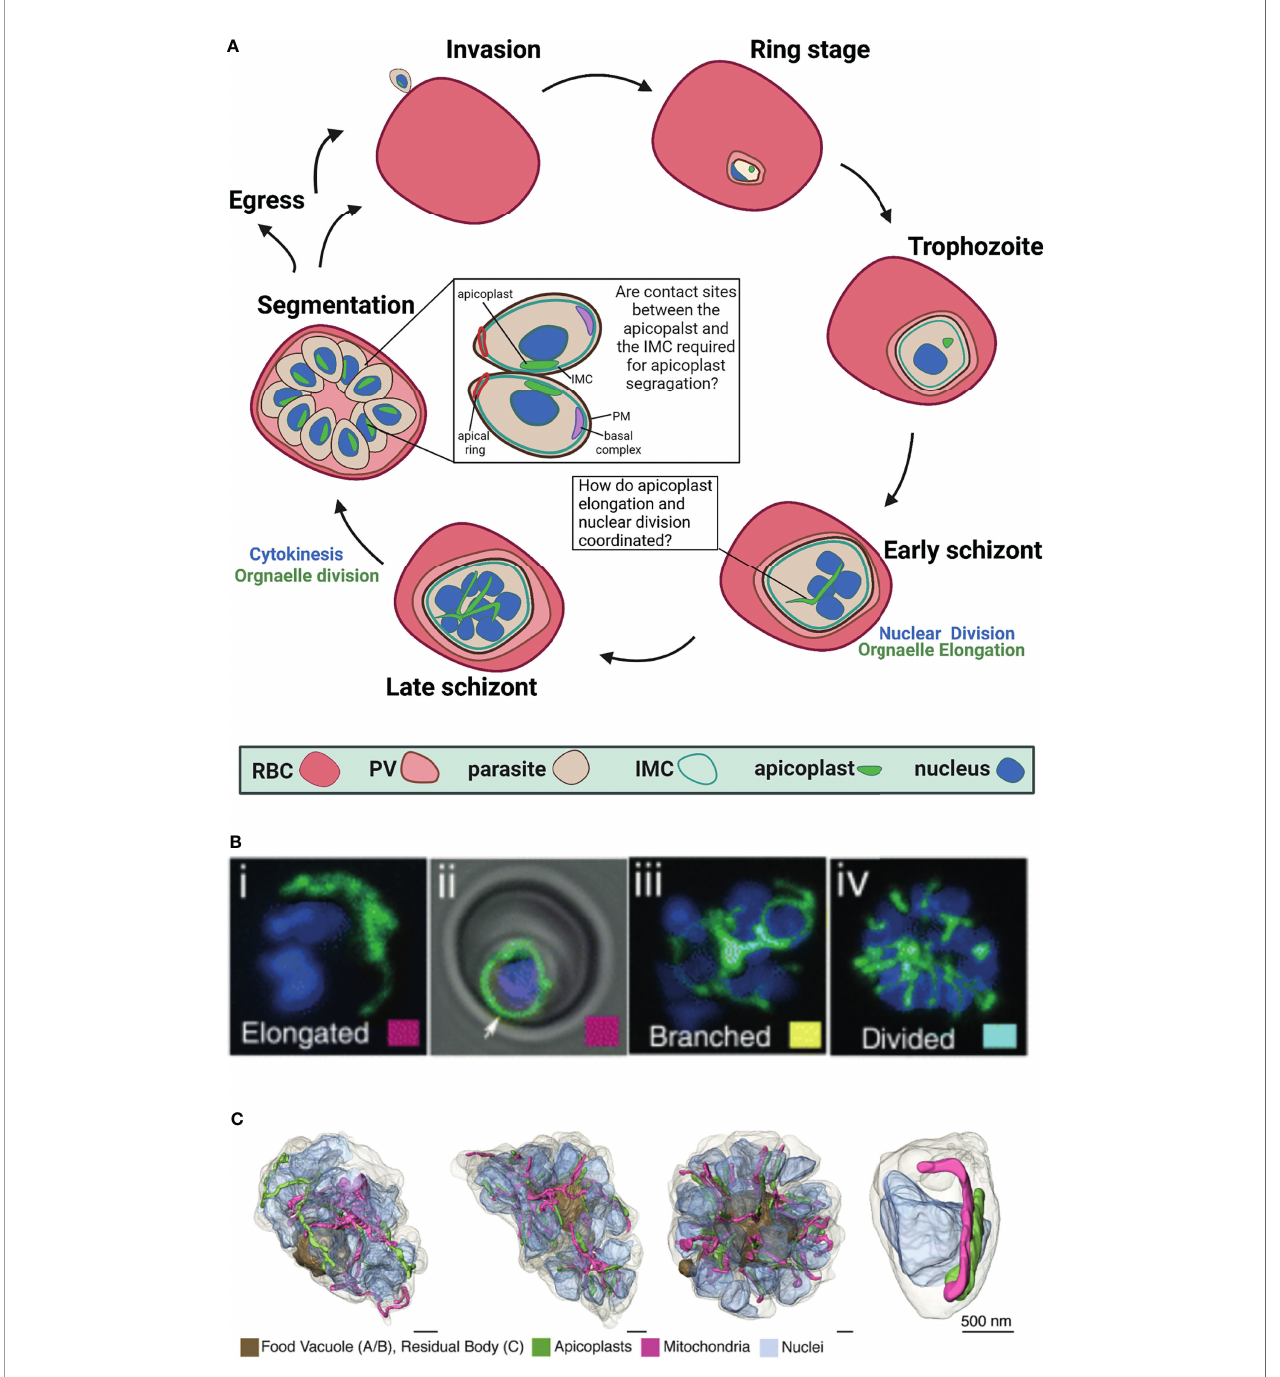
FIGURE 1 | Apicoplast dynamics during intraerythrocytic development of Plasmodium falciparum. (A) Schematic representation of apicoplast dynamics during intraerythrocytic asexual replication of P. falciparum . RBC, red blood cell; PV, parasitophorous vacuole; IMC, inner membrane complex, PM, plasma membrane Created with BioRender.com. (B) Fluorescent microcopy of live apicoplast-tagged parasites (ACP-DsRed) co-labelled with a nuclear Hoechst dye. Apicoplast morphology was categorized into four groups based on developmental stage: (i) rounded (ii) elongated (iii) branched and (iv) divided. Image taken from van Dooren et al. (2005). (C) . Apicoplast morphologies throughout segmentation. By mid-segmentation, apicoplasts have divided to form one organelle for each nascent daughter cell. Ultra-resolution images were obtained using FIB-SEM, taken from Rudlaff et al.